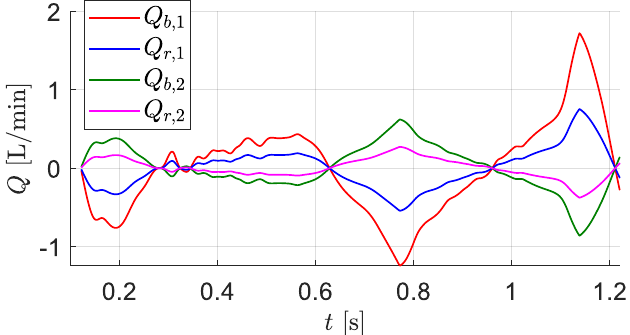
Figure 23. Flow in and out of the cylinder chambers over a gait cycle.